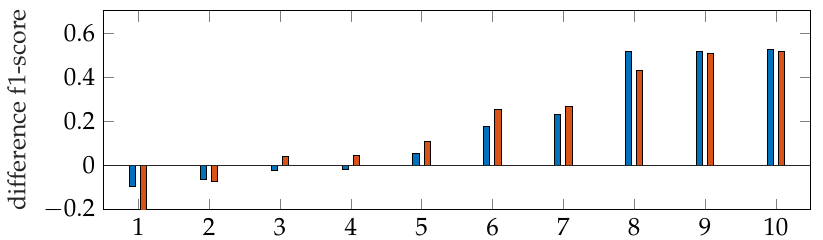
Figure 15. Ascending ordered difference of the f1-score for 10 videos: f1-score of segmentation with windowing subtracted by the f1-score of Dukler et al. (blue) and f1-score of segmentation with windowing subtracted by the f1-score of Corinzia et al. (red).